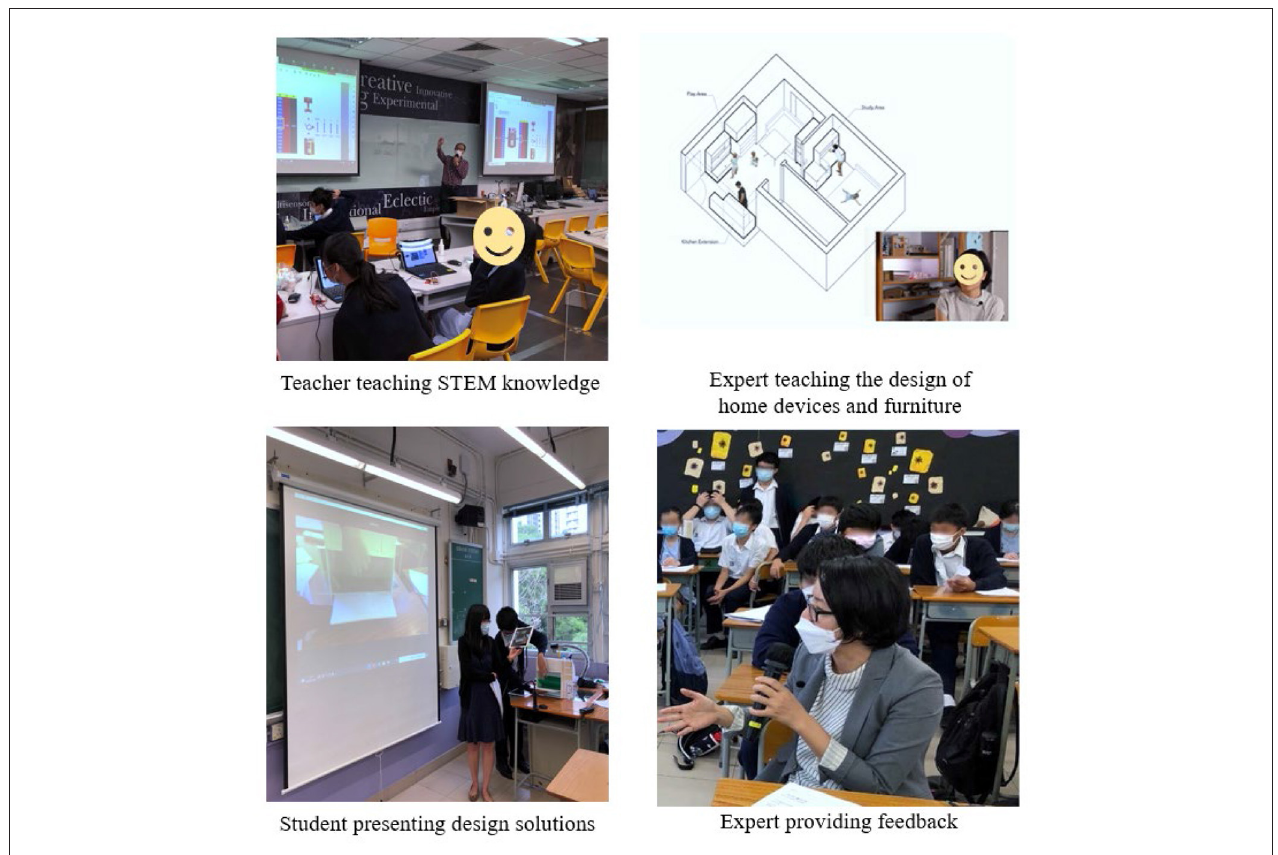
FIGURE 2 | Teaching and learning activities in the